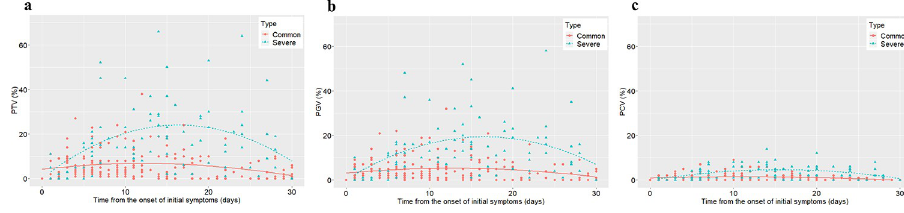
Fig 1. Changes in PTV, PCV and PTV on chest CT from time of onset of initial symptoms (days). Temporal changes in PTV (a), PGV (b) and PCV (c) for each patient. Fitted curve is depicted in each graph. PGV, percentage of ground-glass opacity volume; PCV, percentage of consolidation volume; PTV, percentage of total pneumonia lesion